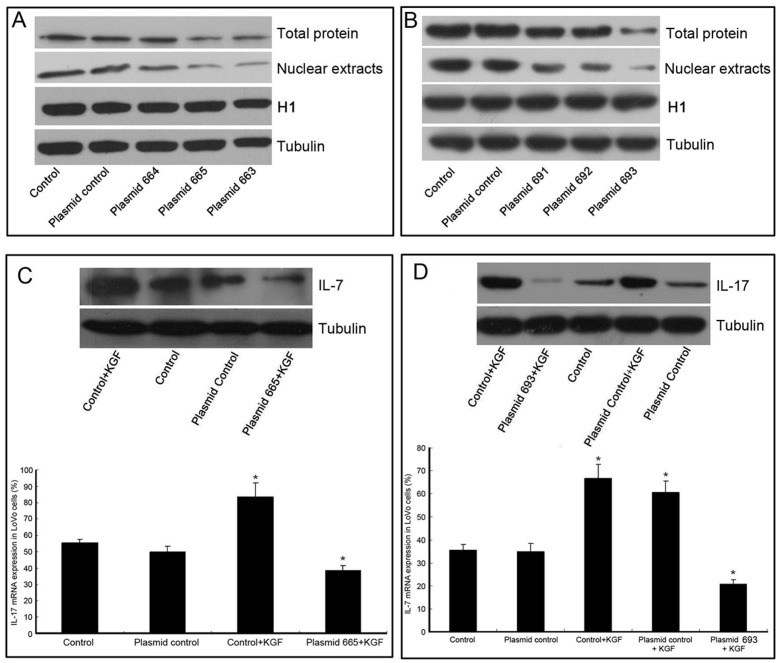
IL-7 is up-regulated by KGF through IRF-1/IRF-2 pathway.Tubulin and H1 were used as internal control. (A) Reduced the nuclear extracts and total proteins of IRF-1 was confirmed by western blot in LoVo cells following IRF-1 RNA interference. Plasmids 663, 664 and 665 were transfected into LoVo cells and IRF-1 expression was detected. Plasmid 665 can definitely inhibit IRF-1 expression. (B) Reduced the nuclear extracts and total proteins of IRF-2 was confirmed by western blot in LoVo cells following IRF-2 RNA interference. Plasmids 691, 692 and 693 were transfected into LoVo cells and IRF-2 expression was detected. Plasmid 693 can definitely inhibit IRF-2 expression. (C) Reduced expression of IL-7 was confirmed by western blot and quantitative real-time PCR in LoVo cells following IRF-1 RNA interference. Decreased expression of IL-7 was observed in LoVo cells following KGF treatment in response to RNA interference of IRF-1 by plasmid 665 in both mRNA and protein levels. *P<0.05 vs. control group. (D) Reduced expression of IL-7 was confirmed by western blot and quantitative real-time PCR in LoVo cells following IRF-2 RNA interference. Decreased expression of IL-7 was observed in LoVo cells following KGF treatment in response to RNA interference of IRF-2 by plasmid 693 in both mRNA and protein levels. *P<0.05 vs. control group.